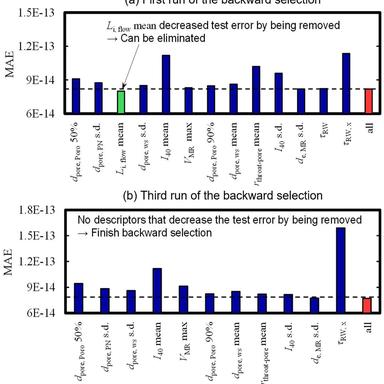
Result of the backward elimination. The vertical axes represent the MAE of the permeability prediction. Only the descriptors on the horizontal axes were removed from the subsets. Here, "all" indicates the prediction error when using all the descriptors in the subsets; it was used as a benchmark.